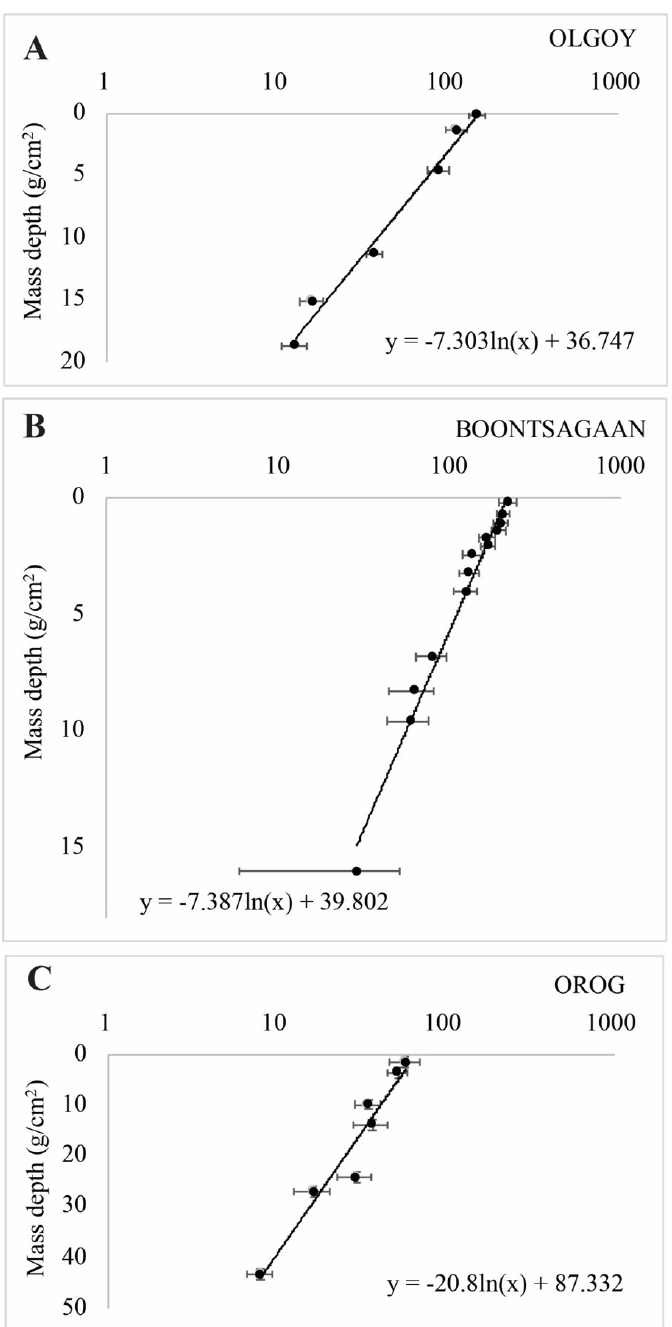
Figure 4. Profile of excess 210 Pb concentration against mass depth of ( A ) Olgoy, ( B ) Boontsagaan, and ( C ) Orog lakes. Shaded data in Table 2 are plotted.